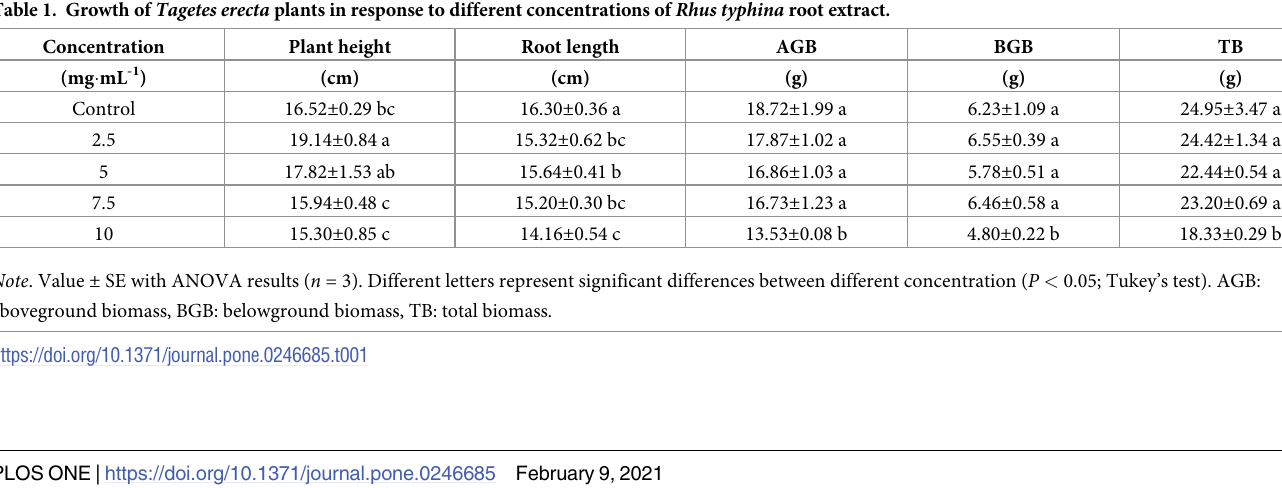
Table 1. Growth of Tagetes erecta plants in response to different concentrations of Rhus typhina root extract. Concentration Plant height Control